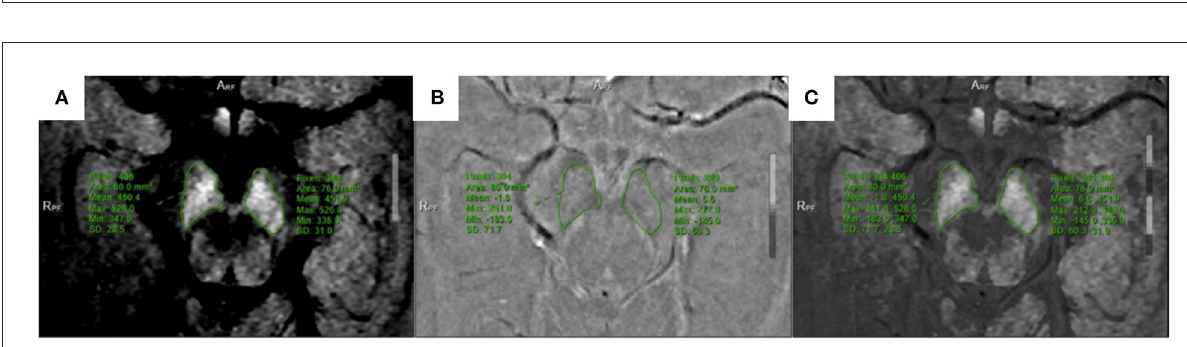
FIGURE2 Located in the middle of SNc. (A) NM-MRI map; (B) SWI-phase diagram; (C) The two images are fused, and the phase value is obtained.